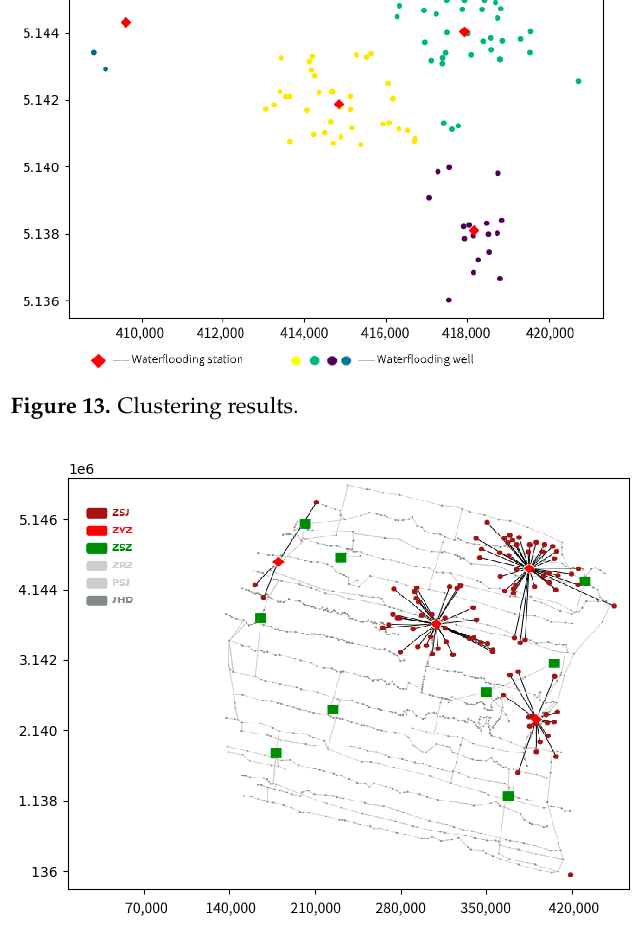
Figure 14. Layout of booster stations. Table 4. Affiliation of high-pressure wells and booster stations.